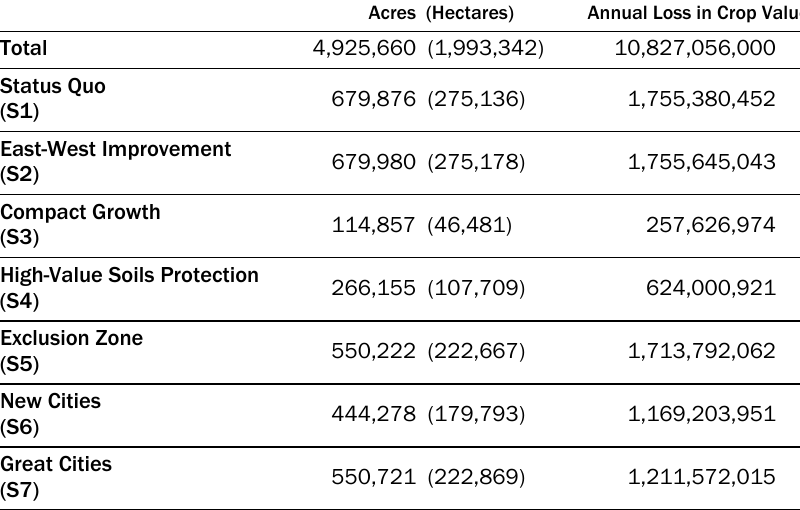
Table 2. Acres (Hectares) Included in Value Calculations and Associated Annual Loss of Revenues (2004